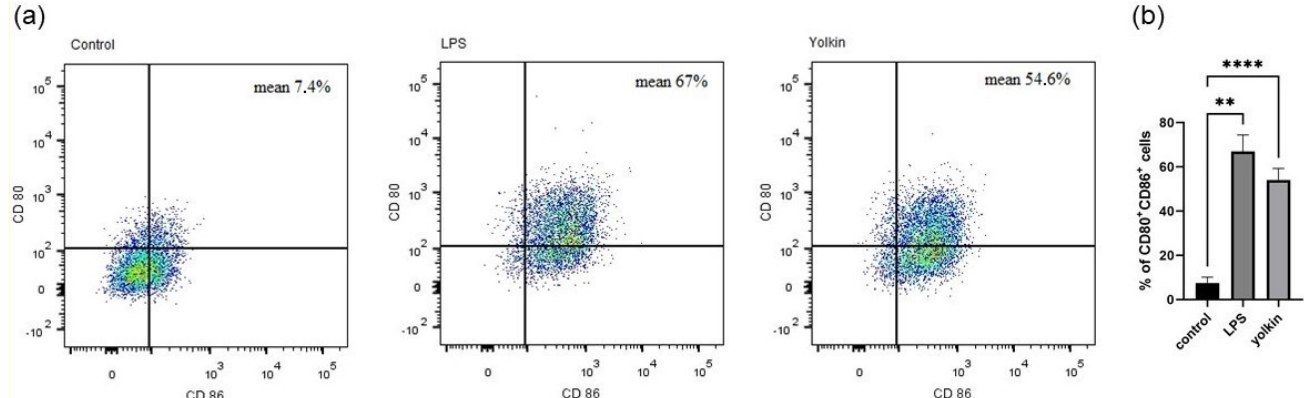
Figure 4. Analysis of co-expression of CD80 and CD86 on BMDM cells. The cells (3 × 10 5 /mL) were stimulated with yolkin (100µg/mL) or LPS (1 µg/mL) for 24 h and then stained with fluorescent CD80 (1:100) and CD86 (1:100) mouse antibodies. The cells were analyzed using FACS. The results represent three independent experiments with representative flow cytometry dot plots ( a ) and a graph summarizing the changes, presented as median with SD ( b ). The cells stimulated with yolkin or LPS were compared with the non-stimulated control cells. The post-measurement analysis was performed using FlowJo VX.07 software and data were analyzed with a one-way ANOVA (Brown–Forsythe and Welch’s test). ** p ≤ 0.005; **** p ≤